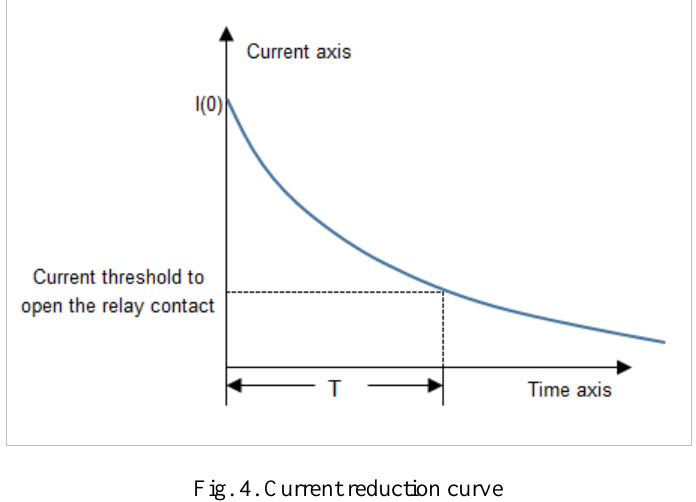
Fig. 4. Current reduction